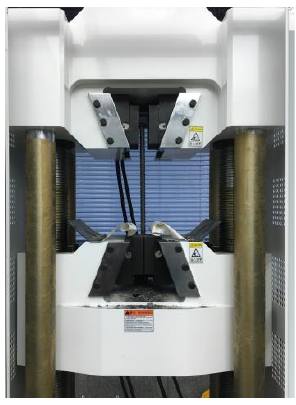
Figure 6. Test on rebar properties. Table 7. HRB400 rebar material properties.